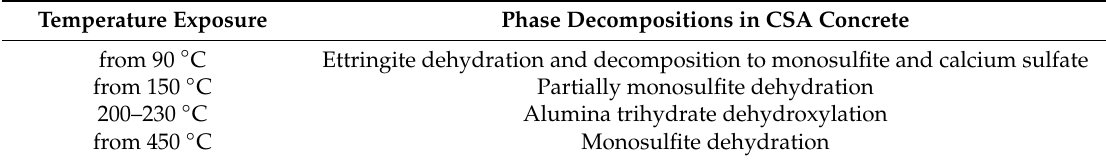
Table 2. Calcium sulfoaluminate (CSA) phase